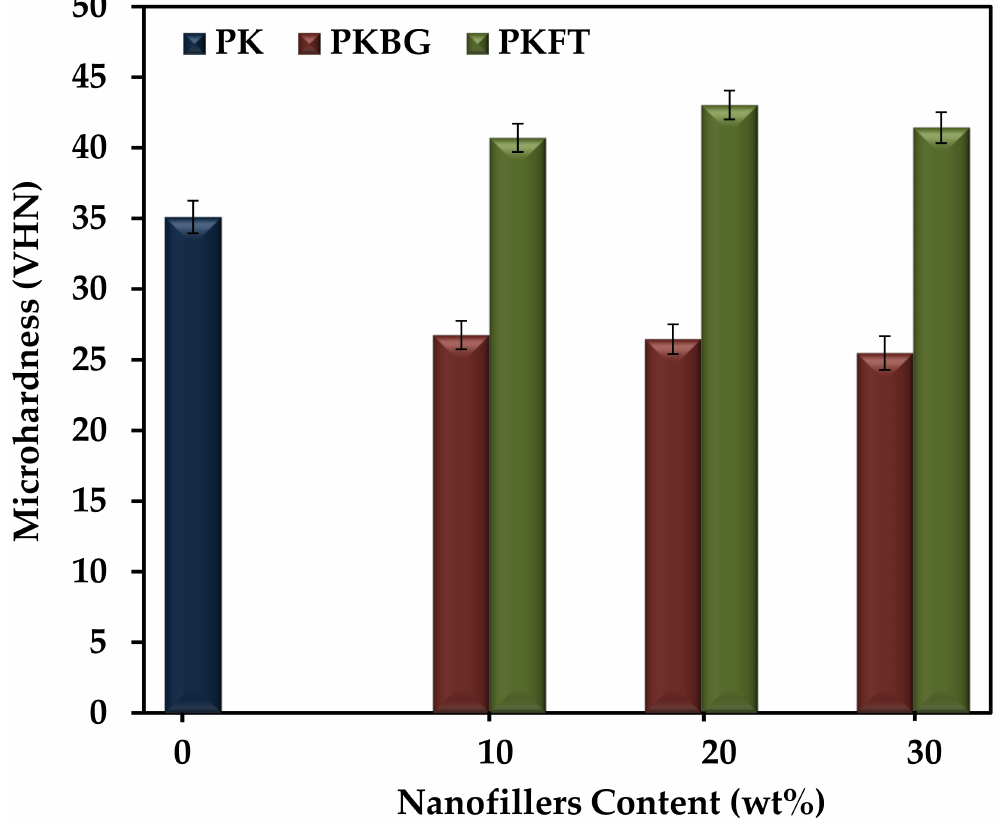
Figure 3. Variations of microhardness (mean ± SD) of the PEEK nanocomposites as a function of the nanofillers content. ( n = 6, p <